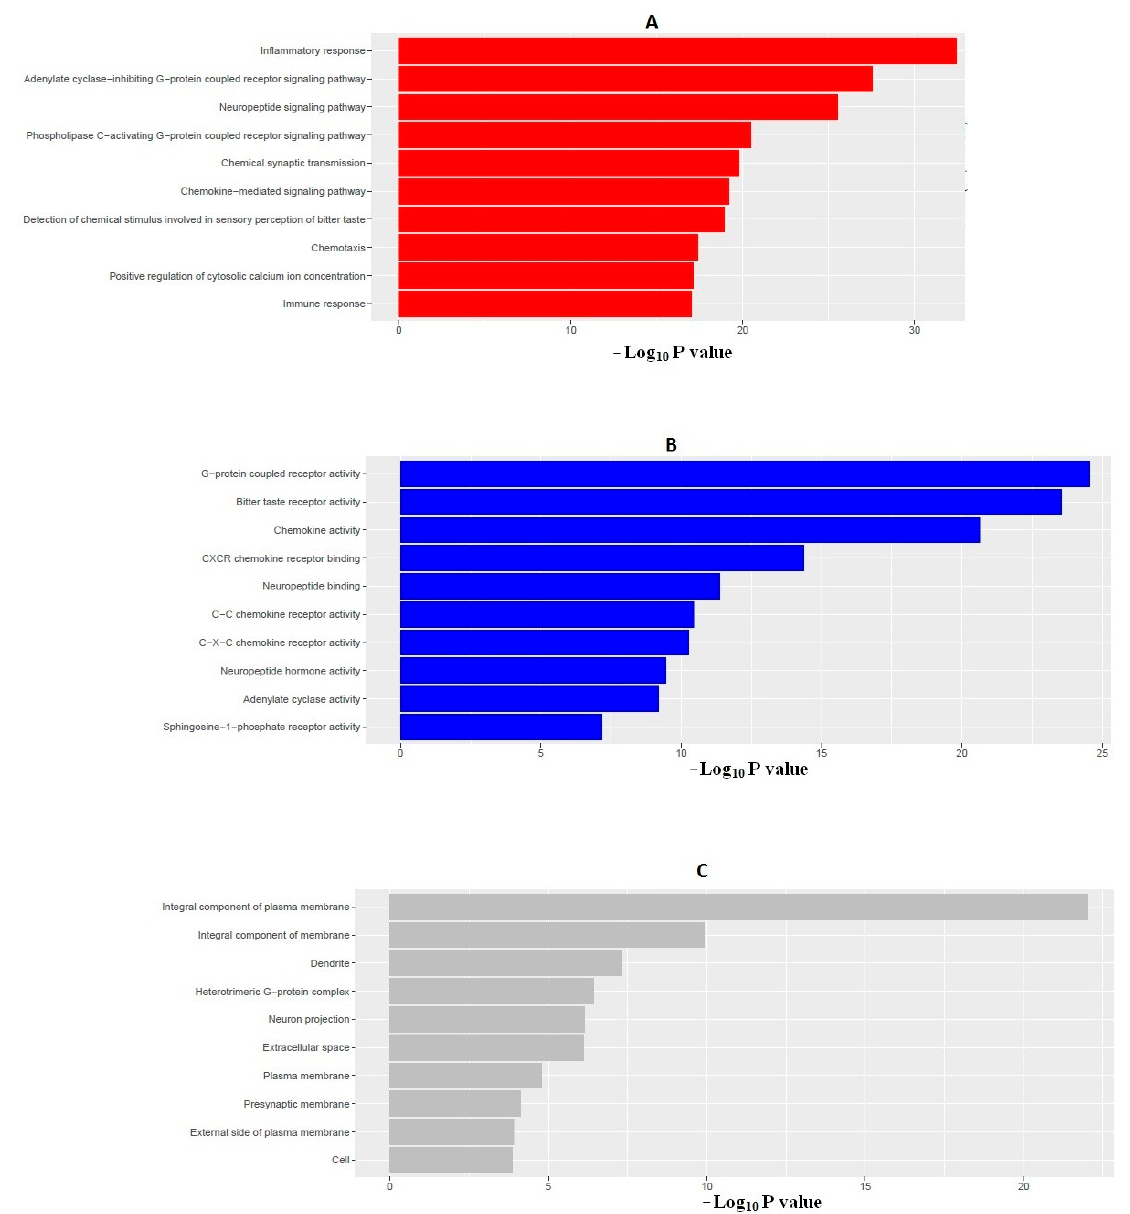
Figure 9. Gene Ontology (GO) enrichment analysis of the interacted target proteins: ( A ) top 10 biological processes (red); ( B ) top 10 molecular functions (blue); and ( C ) top 10 cellular components (gray).